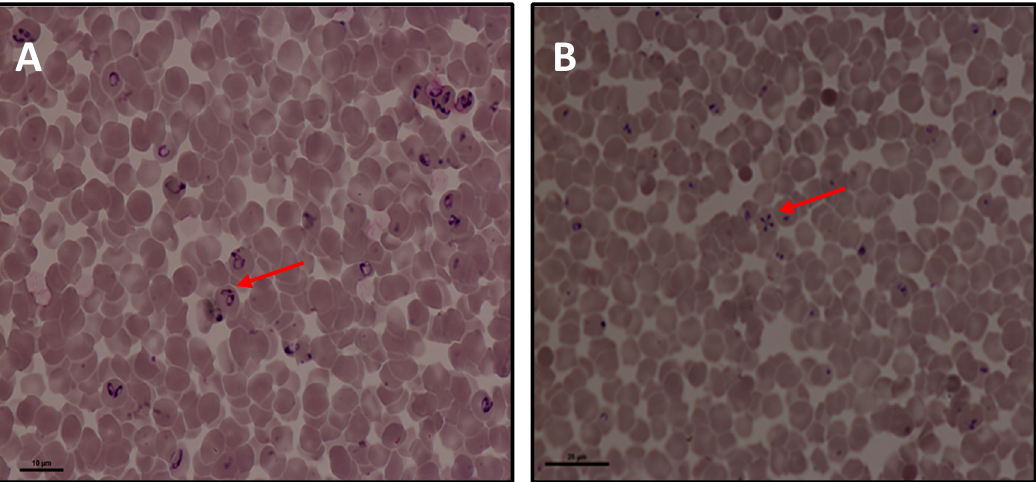
Figure 2. Photomicrograph of Giemsa stained blood smear in Equine Piroplasmosis (EP) parasites prepared from in vitro cultures. ( A ) Babesia caballi and ( B ) Theileria equi . The arrow on ( A )indicates the two pear-shaped bodies of B. caballi joined at the posterior end; on ( B ) indicates the four shaped merozoites of T. equi referred to as the “maltese cross”.